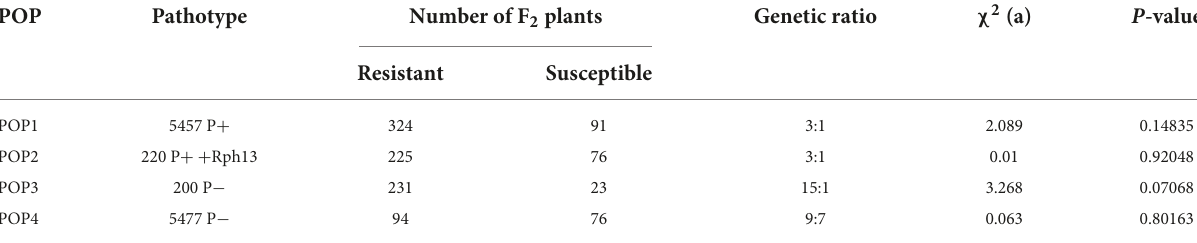
( Figure 4 ). Due to the telomeric location of the locus,